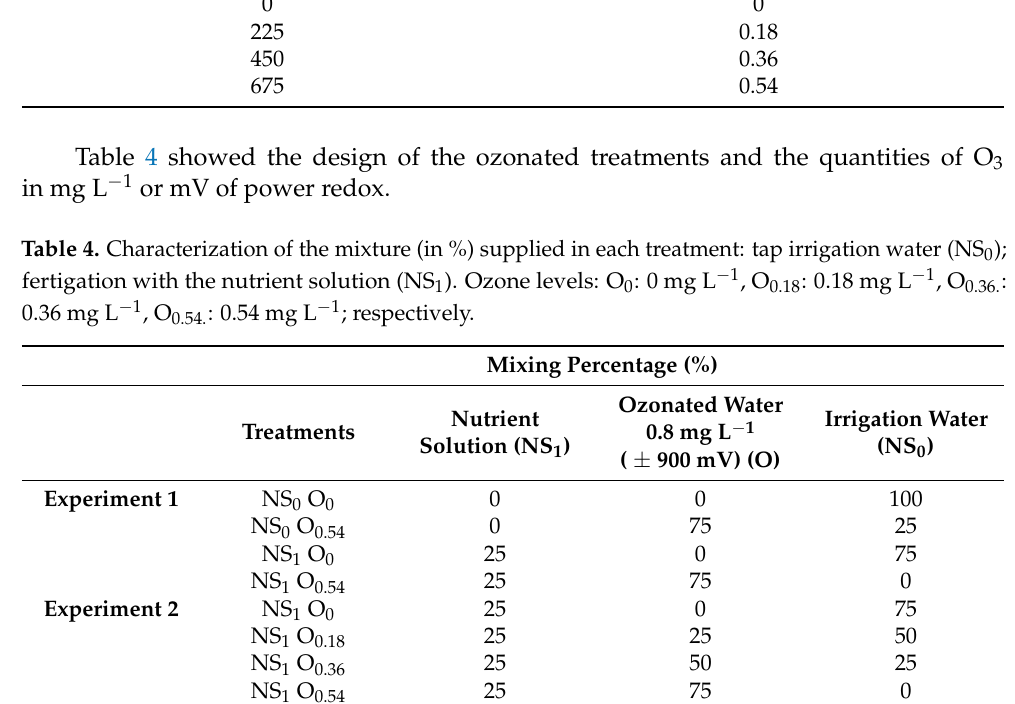
Table 3. Conversion from power redox (mV) to O 3 concentration (mg L − 1 ) in the ozone machinery. Power Redox (mV)